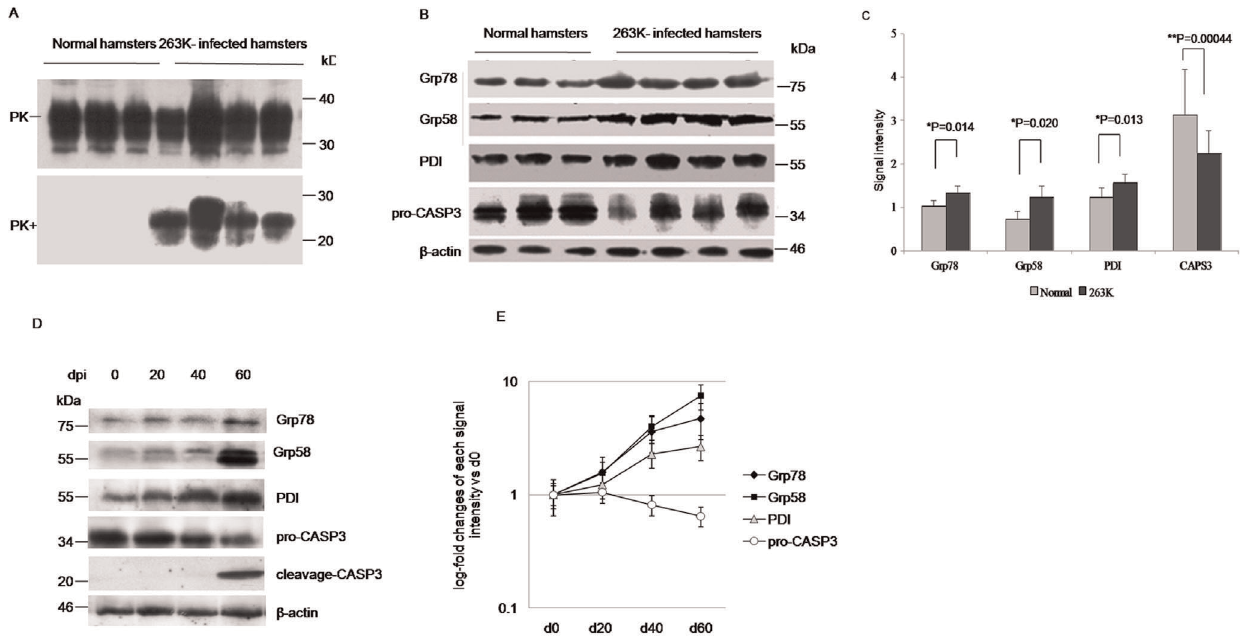
Figure 1. Comparative analysis of the levels of PDIs in the brain tissues of normal and 263K-infected hamsters. A. Western blots. The infected hamsters were collected about 60 to 70 dpi. Same amounts of individual brain homogenate were loaded in 15% SDS-PAGE and immunoblotted with PrP specific mAb 3F4. PK + : with PK (50 m g/ml); PK-: without PK. B. Western blots of Grp78, Grp58, PDI and pro-caspase3. C. Quantitative analysis of each gray numerical value of Grp78, Grp58, PDI and pro-caspase3 vs that of individual b -actin. The average values are calculated from four infected hamsters or three normal hamsters and presented as mean 6 SD. Statistical differences compared with controls are illustrated. D, Dynamic analyses of Grp78, Grp58, PDIs, pro-caspase3 and cleveage-caspase3 in the brain tissues of scrapie agent 263K-infected hamsters collected on 0, 20, 40 and 60 dpi during incubation period with Western blots. E. Log-fold changes of the gray values of Grp78, Grp58, PDIs, pro-caspase3 in the 263K-infected hamster’s brains collected on 20, 40 and 60 dpi vs that of 0